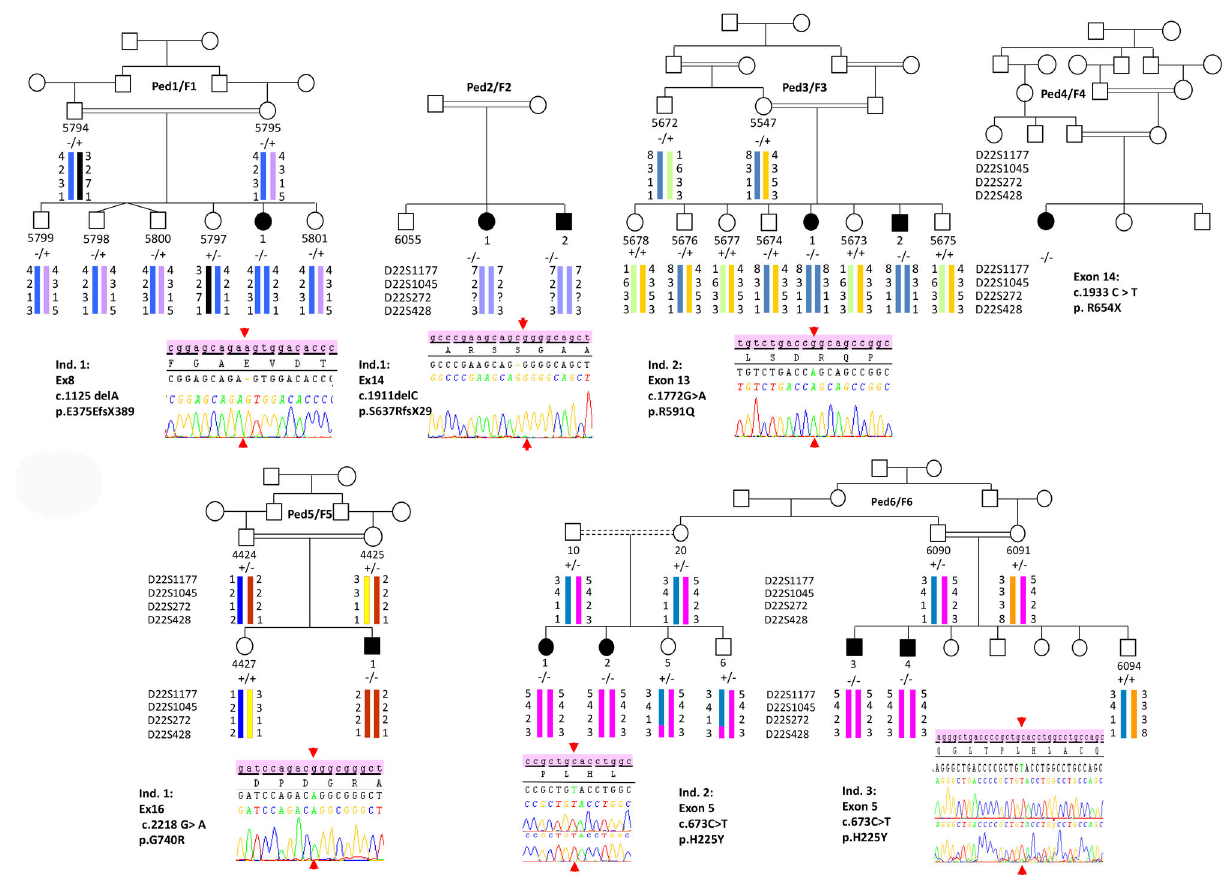
Figure 6. Genetics findings. Pedigrees (Ped) of the six Saudi Arabian families (F1-6) are represented in the same order as in the tables and in Figure 7. Patients were also numbered according to the Tables. Haplotypes were reconstructed manually (Family F4 was not subjected to genotyping) and chromatograms of each identified mutation are shown, except Family F4 which had direct sequencing in a private company. The segregation of the mutation, when possible, was shown for each pedigree with the corresponding symbols (“+”= wild type and “-“= mutated).